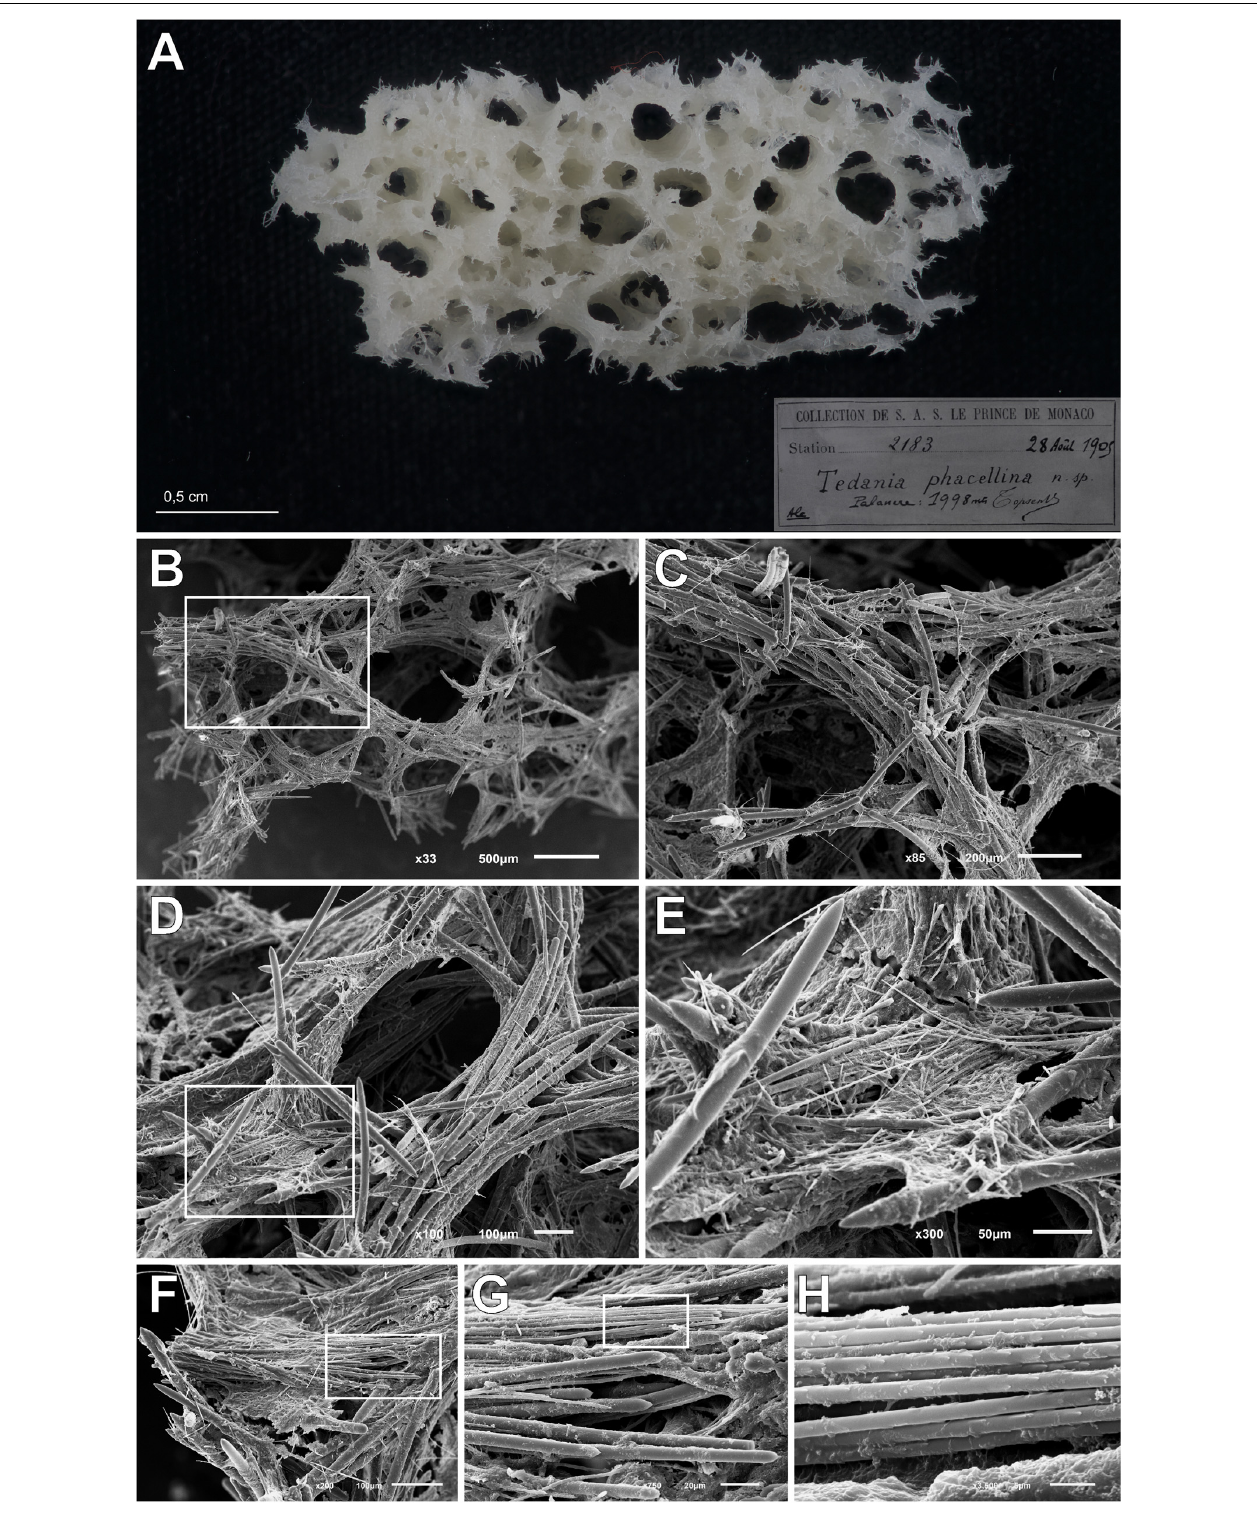
FIGURE 7 | Tedania ( Tedaniopsis ) phacellina , Topsent, 1912. (A) Schyzotype, the small fragment extract from the holotype used in this paper. (B,C) Section of choanosomal skeleton where the bundles of styles can be seen. (D,E) Skeleton around the aquiferous system composed of multispicular tracts and styles; onychaetes covering the tracts and imbibed in the spongin can be seen. (F,G) Bundles of ectosomal tornotes. (H) Onychaetes in trichodragmata.